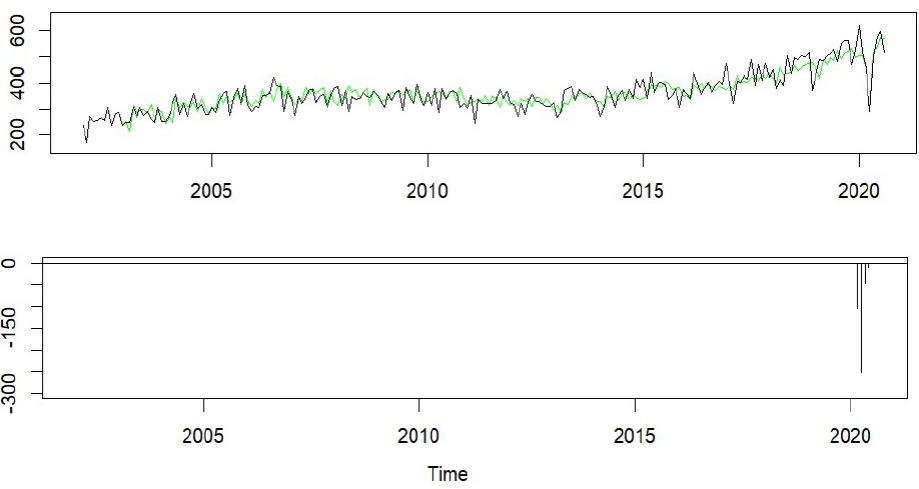
Figure 13. Hispanic donor transplant counts with the model fit ( top ) and the estimated COVID-19 effects ( bottom